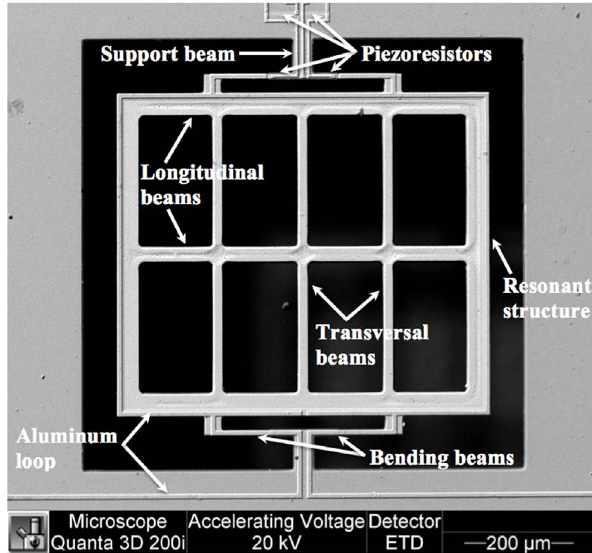
Figure 1. SEM image of the resonant structure of the MEMS magnetic field sensor.